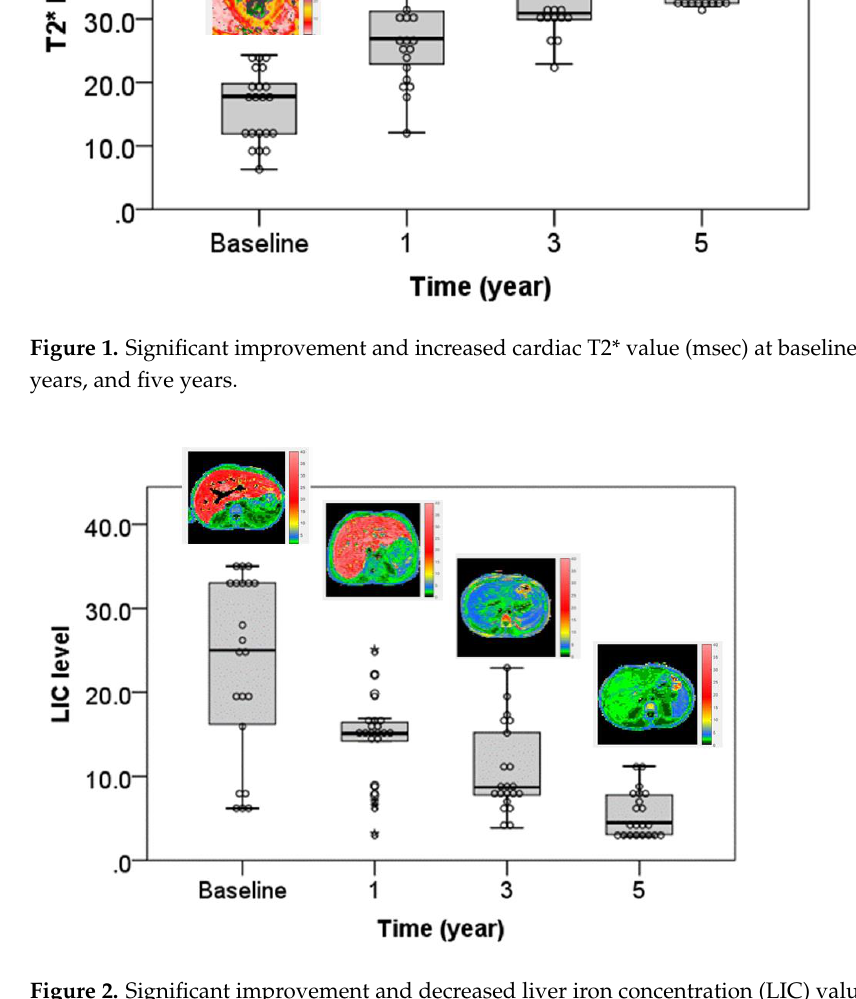
Figure 2. Significant improvement and decreased liver iron concentration (LIC) value (mg/g dw) at baseline, one year, three years, and five Figure 2 . Significant improvement and decreased liver iron concentration ( LIC ) value ( mg / g dw ) at baseline, one year, three years, and five years .